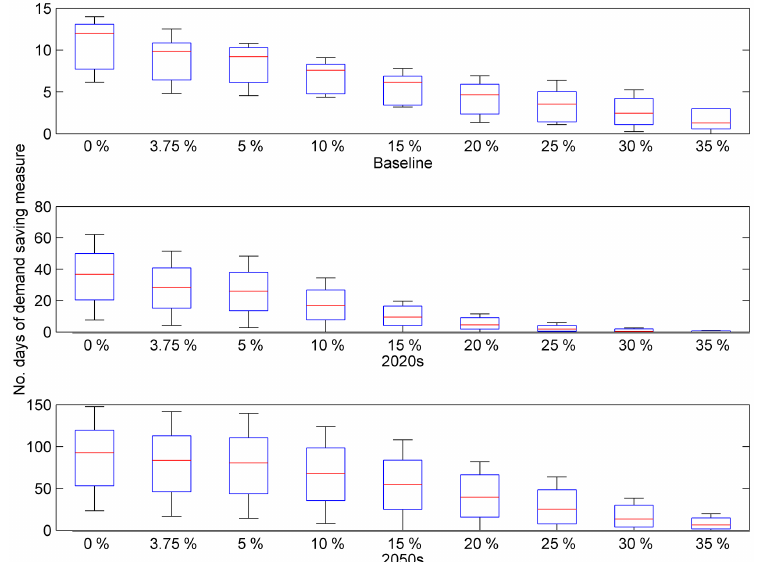
Figure 9. Number of DS4 days per 100 years for BSL, SCN20, and SCN50 under climate and population projections, for a range of reductions in per capita demand. Box plots indicate the median, 25th, and 75th percentile values; whiskers show the 10th and 90th percentile